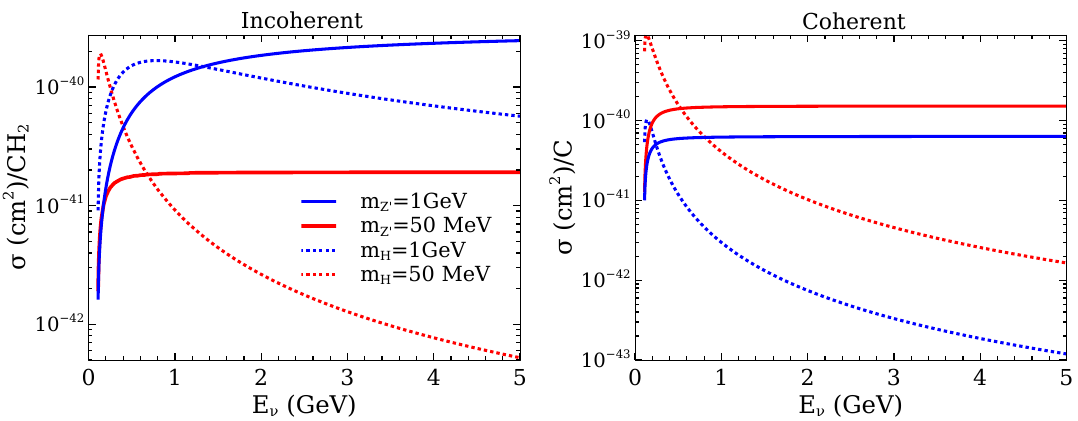
Figure 2. The incoherent (coherent) cross section per CH 2 molecule (C atom) as a function of incoming neutrino energy. The overall constants for different kinds of mediator masses are taken from table